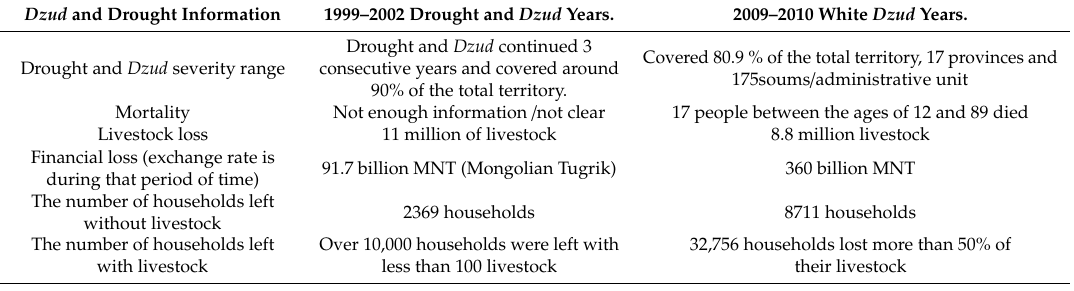
Table A2. Economic loss caused by drought and Dzuds in